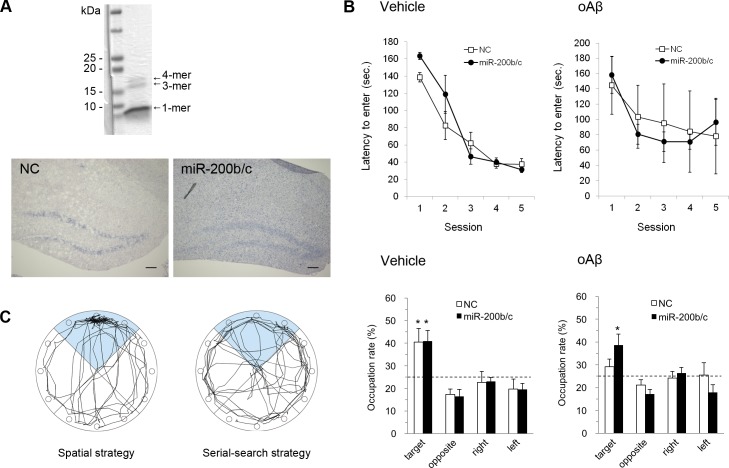
Defensive effect of miR-200b/c on oligomeric Aβ-induced learning impairments in vivo.(A) Upper image: Coomassie brilliant blue-stained oAβ following separation using SDS-PAGE gels. Both 4-mer and 3-mer Aβ were reliably observed. Lower images: In situ hybridization image showing detection of the miR-200b probe in the hippocampi of NC (left) and miR-200b/c (right) i.c.v.-infused mice. The hippocampi from the mice overexpressing miR-200b/c exhibited higher intensity digitoxin labeling than NC hippocampi. Scale bar, 100 μm. (B) Upper graphs: the latency to enter a goal hole during the training sessions over 5 days in the vehicle (left) and oAβ (right) groups. In both groups, NC- and miR-200b/c-treated mice showed improved performance with the number of sessions (two-way ANOVA, F (4, 40) = 50.0, p < 0.00001). Lower graphs: percentage of time spent in each quadrant for the vehicle- (left) and oAβ- (right) treated groups during the probe test. The results of the probe test showed that spatial learning in miR-200b/c-infused mice was not influenced by oAβ (Chi-square test, *p < 0.01). (C) Representative path tracing of mice using a spatial strategy (left) and a serial-search strategy (right).